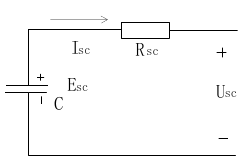
Figure 3. Equivalent circuit of ultra-capacitors.